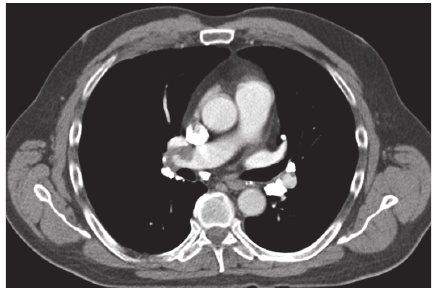
Figure 3: Computed tomography of the chest depicting filling defects in the pulmonary arterial vasculature secondary to pul- monary embolism and probable right middle lobe